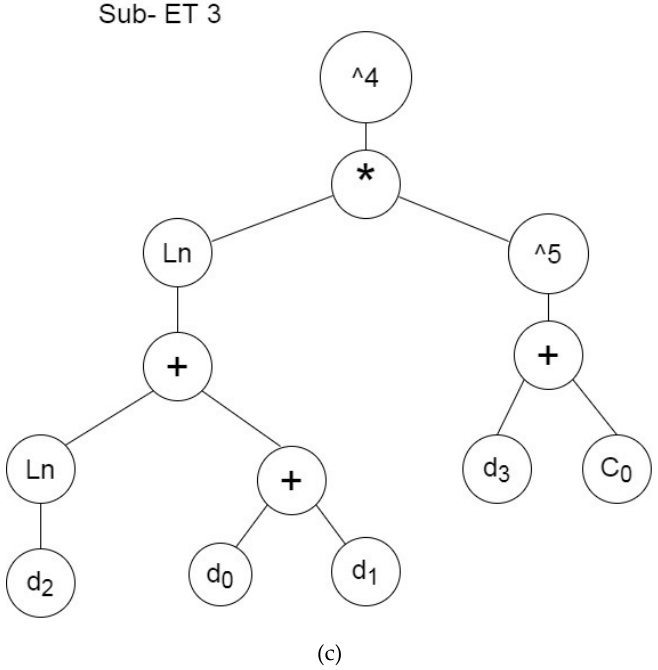
Figure 12. Expression trees of GEP1 for tensile strength ( a ) sub-ET1, ( b ) sub-ET2, ( c ) sub-ET3.